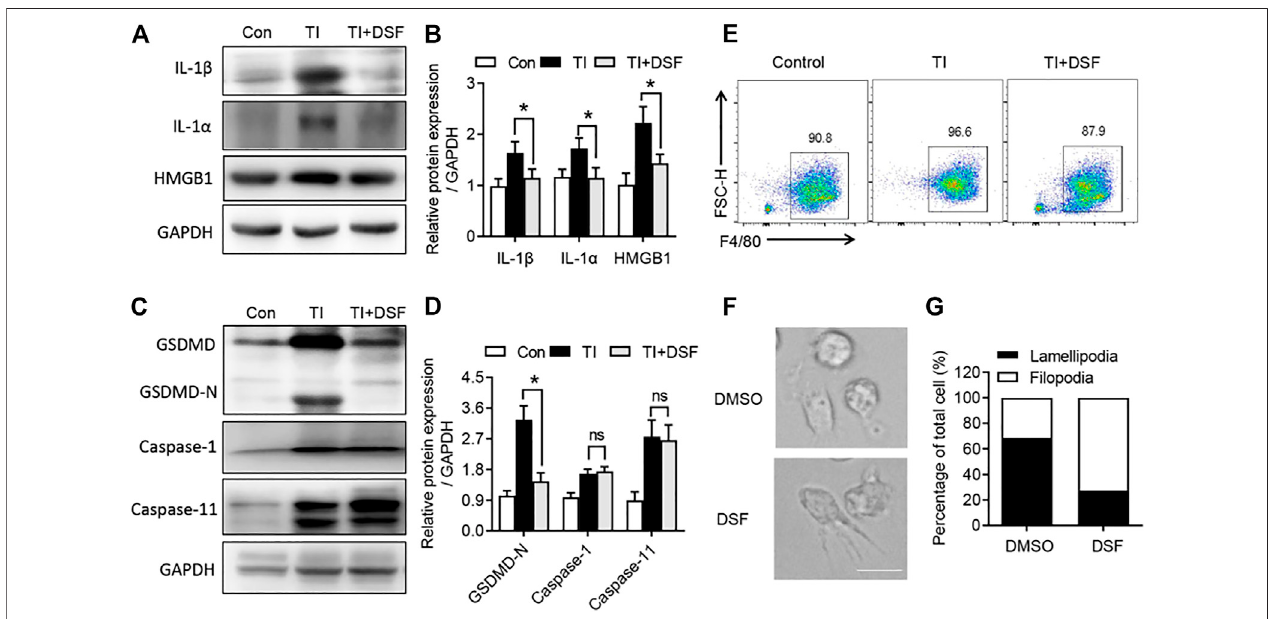
FIGURE 4 | DSF inhibited GSDMD-dependent cell pyroptosis and in fl ammatory cytokine release. (A) Western blot analysis of IL-1 β , IL-1 α , and HMGB1 in tendon from control, TI, and TI oral with DSF mouse groups. (B) Quantitative analysis of IL-1 β , IL-1 α , and HMGB1 in A . (C) Western blot analysis of GSDMD, GSDMD-N, caspase-1, and caspase-11 in tendon from theindicated groups. (D) Quantitativeanalysis ofGSDMD-N, caspase-1, and caspase-11 in C . (E) FACS of M-CSF-induced macrophages (F4/80 + ) from control, TI, and TI oral with DSF mouse groups. (F,G) BMDMs were pretreated with DMSO or DSF (5 μ M) for 2 h. Then the cells were treated with LPS (100 ng/ml), IFN- γ (20 ng/ml), and IL-4 (20 ng/ml) for 6 h. The morphology of macrophages was observed by differential interference-contrast microscopy (F) and ratios of lamellipodial to fi lopodial macrophages (G) . Data are presented as the mean ± SEM ( n = 6) (B, D) . * p < 0.05.